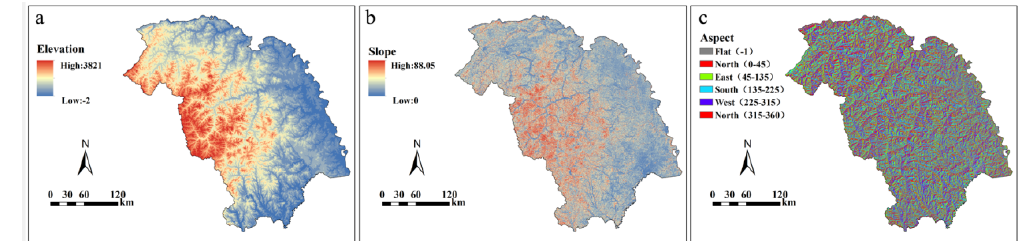
Figure 3. Elevation ( a ), slope ( b ), and aspect ( c ) throughout the study area.